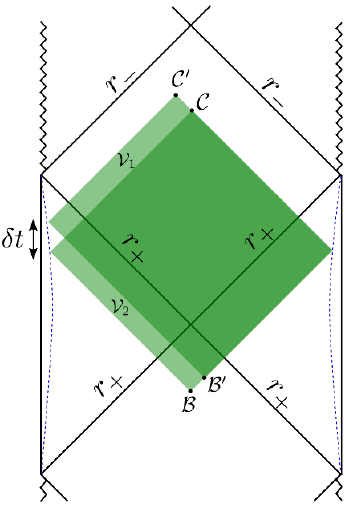
Figure 2 . WdW patch for a near-extremal (cold) hyperbolic black